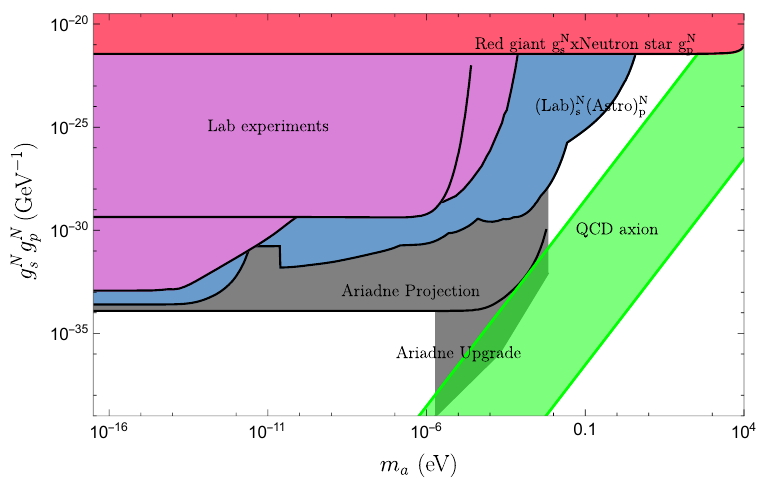
Figure 4 . Limits on CP -violating monopole-dipole interactions for nucleons, adapted from [126]. Purple is different LAB exclusion limits, blue is astro-lab exclusion, gray is the projected limits for ARIADNE. The QCD axion prediction is in green